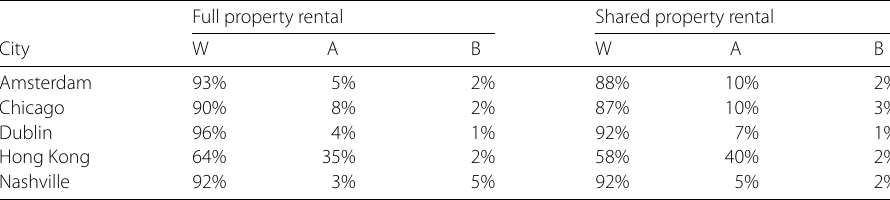
Table 2 Airbnb host and guest population by gender (F = female) Full property rental Shared property rental City F Host F Guest F Host F Guest Amsterdam 59% 55% 59% 58% Chicago 61% 58% 57% 56% Dublin 61% 59% 58% 59% 59% Table 3 Airbnb host population by race (W = White, A = Asian, B = Black) Full property rental Shared property rental City W A B W A B Amsterdam 93% 5% 2% 88% 10% 2% Chicago 90% 8% 2% 87% 10% 64% 35% 2% 58% 92% 92%